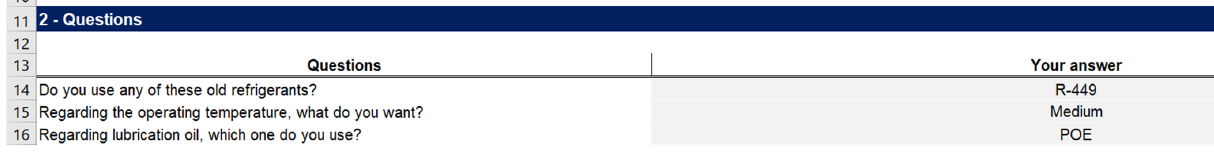
Figure 3. Filling in the parameters of the restrictions in the case of R-449.